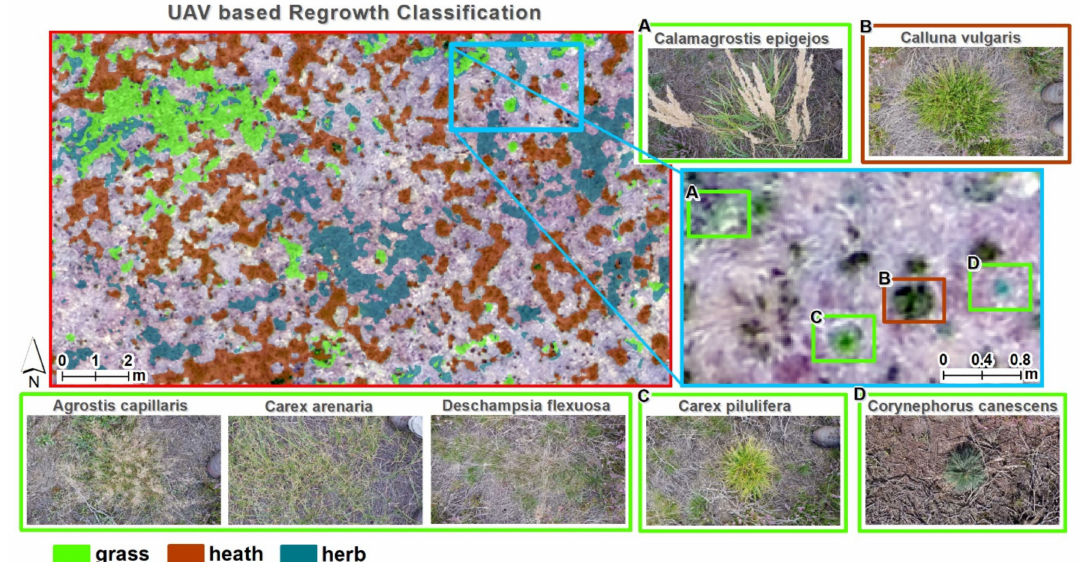
Figure 3. Classified patterns of after-mowing vegetation regrowth aggregated for different grass species; the image extent used is the red bounding box from Figure 1 using an unmanned aerial vehicle (UAV) image recorded at 27 July 2020.